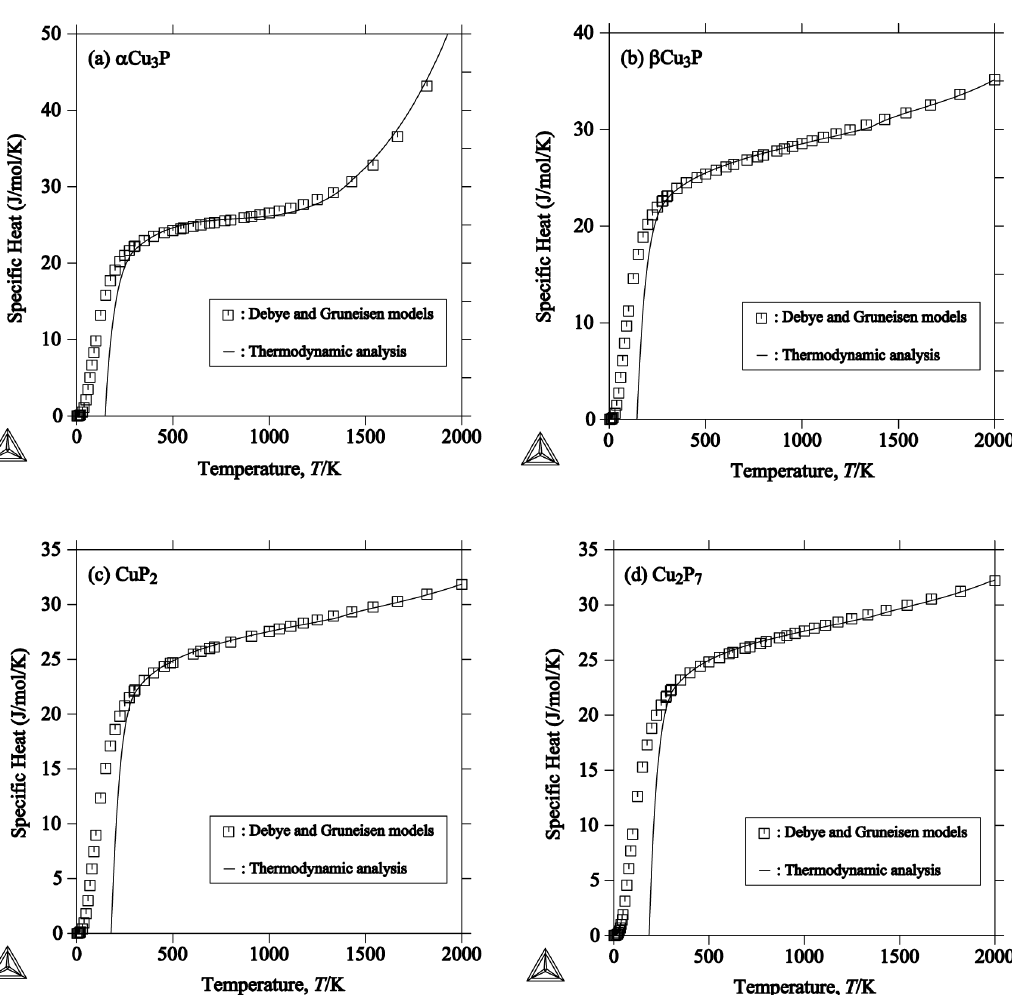
Figure 2. Calculated specific heat of (a) ˛ Cu 3 P, (b) ˇ Cu 3 P, (c) CuP 2 and (d) Cu 2 P 7 in the present thermodynamic analysis.